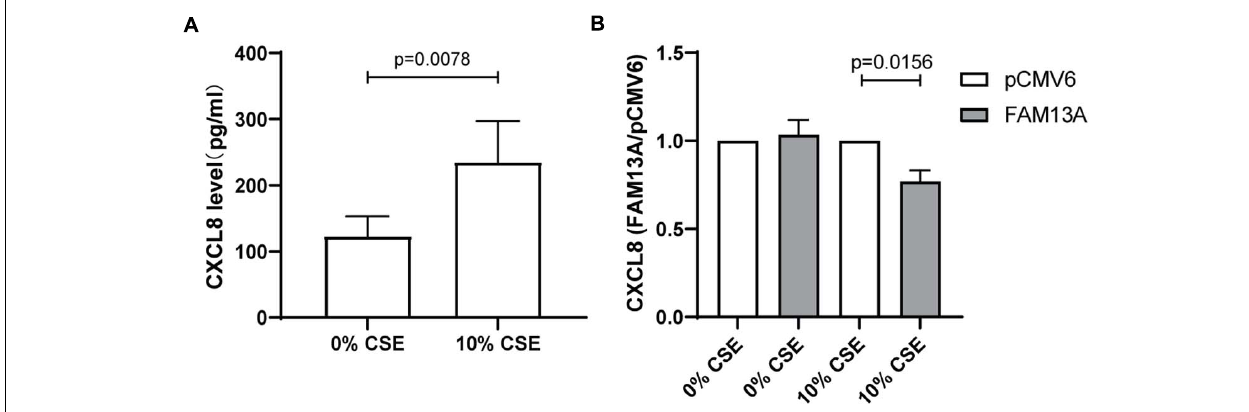
FIGURE 6 | Suppressive effect of FAM13A on CSE-induced CXCL8 secretion in 16HBE14o- cells. 16HBE14o- cells were seeded in duplicate, transfected with FAM13A overexpression plasmid or empty vector (pCMV6), serum deprived overnight and exposed to 10% CSE for 24 h. CXCL8 secretion levels were measured using ELISA. (A) Absolute CXCL8 levels in pCMV6 transfected cells upon CSE exposure. (B) CXCL8 secretion levels of FAM13A overexpressing cells were measured as above and normalized to the levels of pCMV6 cells of each CSE concentration, respectively, ( n = 8). Data are shown as mean ± SEM ( n = 8). Significant differences were assessed by the Wilcoxon signed rank test and the p -value is